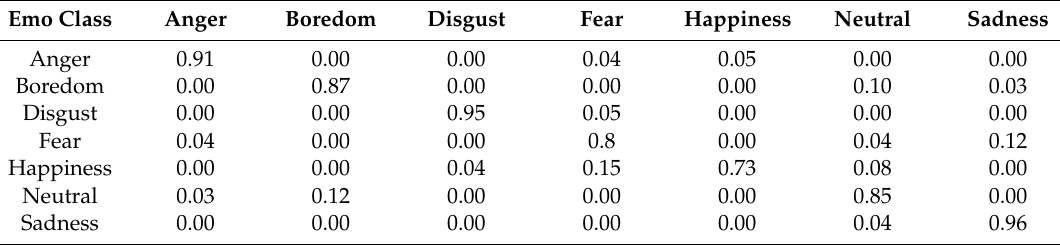
Table 8. Confusion matrix for emotion prediction on EmoDB using RAVDESS and TESS. Emo Class